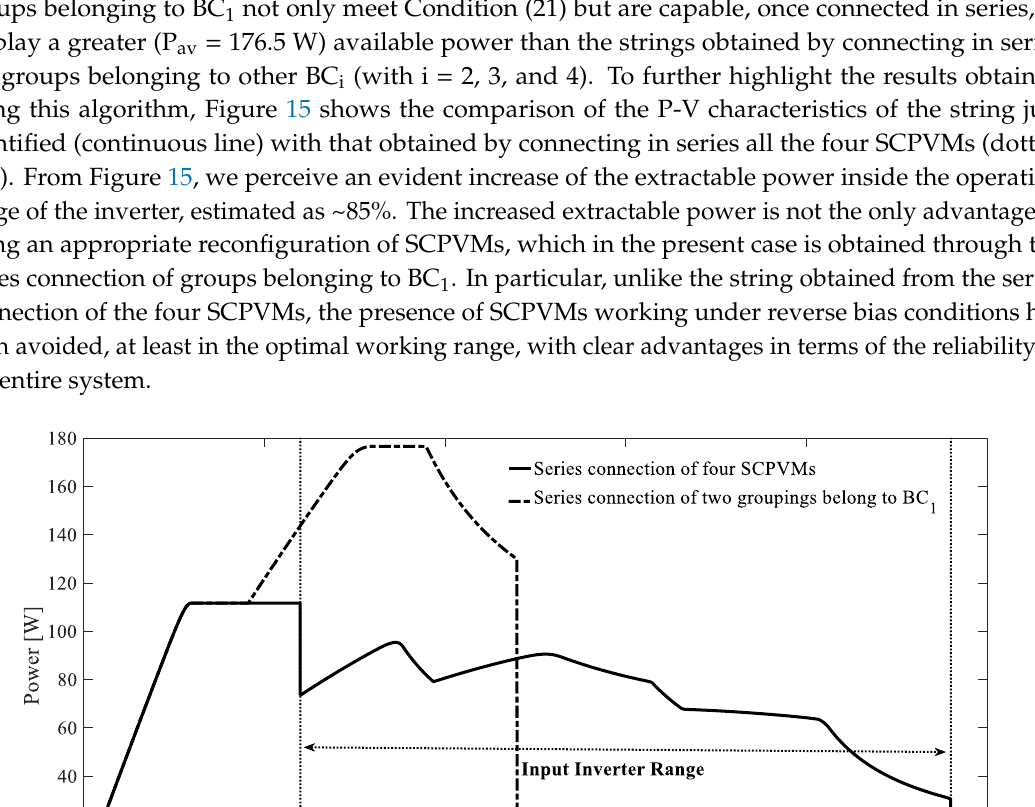
Table 4. Best clusters (BCs) and clusters of excluded (CEs) (Case I).